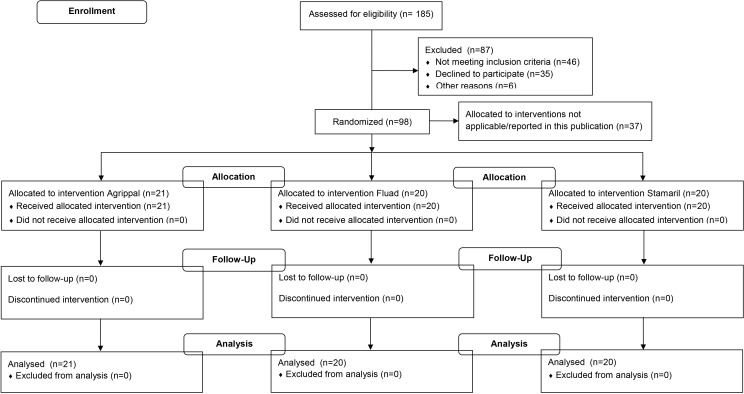
CRC305A and CRC305C study flow charts.